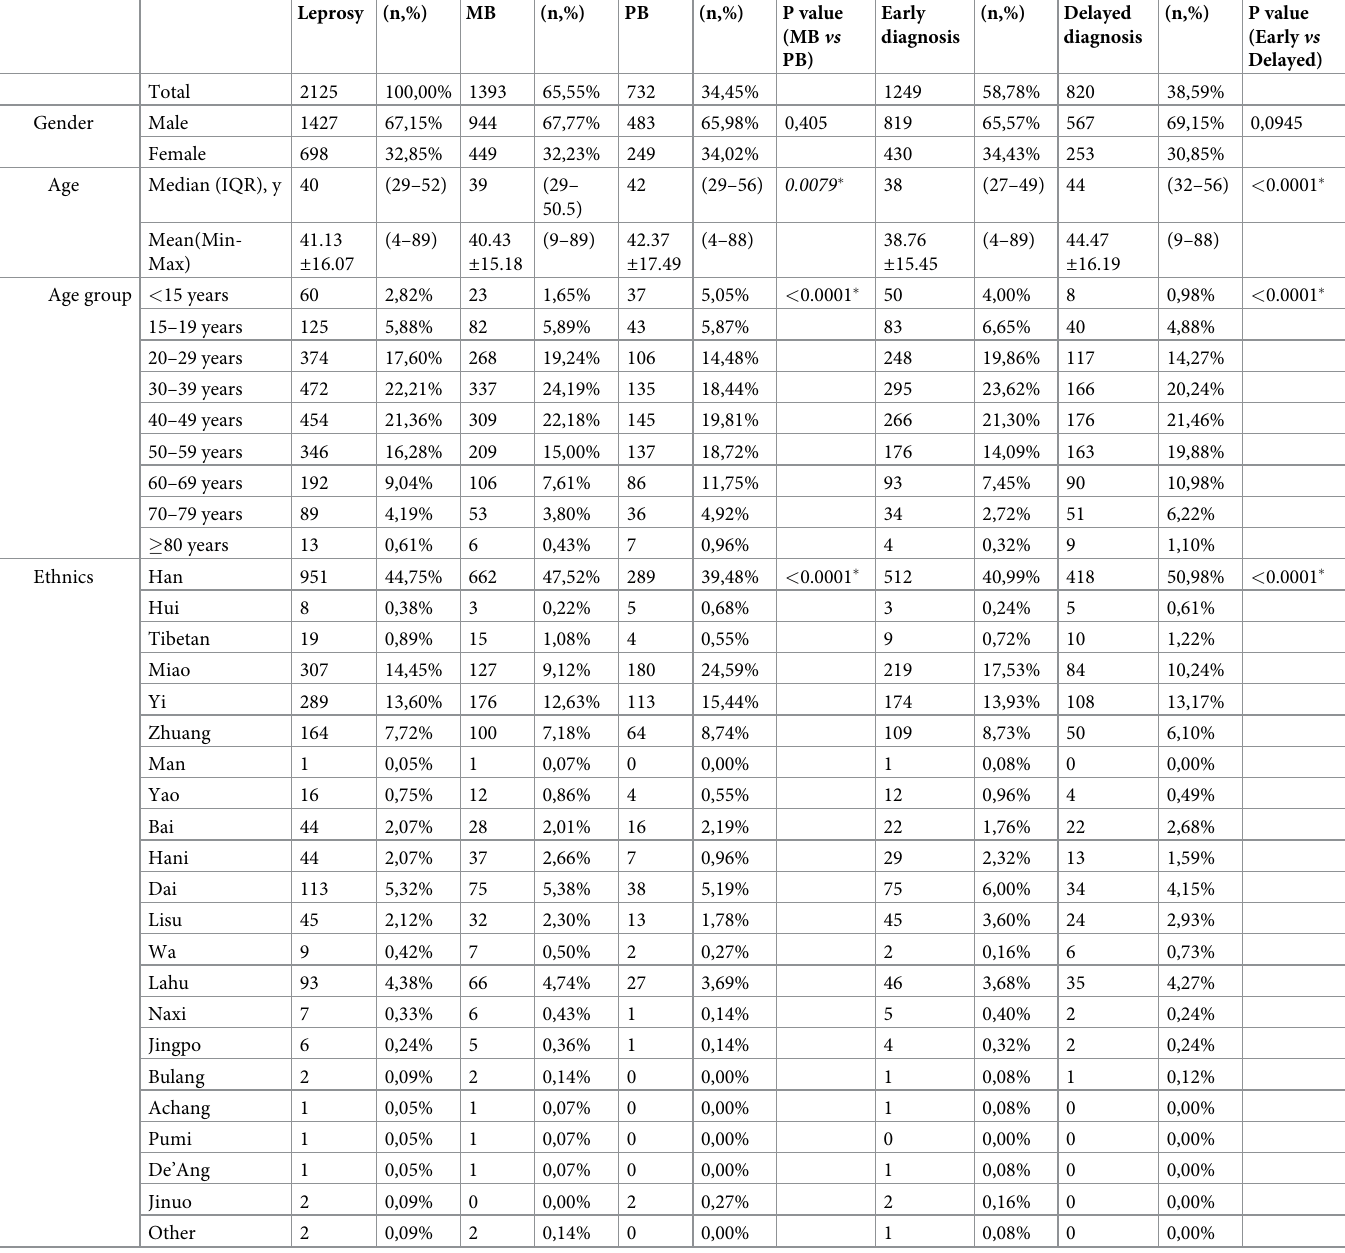
Table 1. Basic Characteristics of the Newly Detected Leprosy Cases Enrolled in This Study in Yunnan, China from